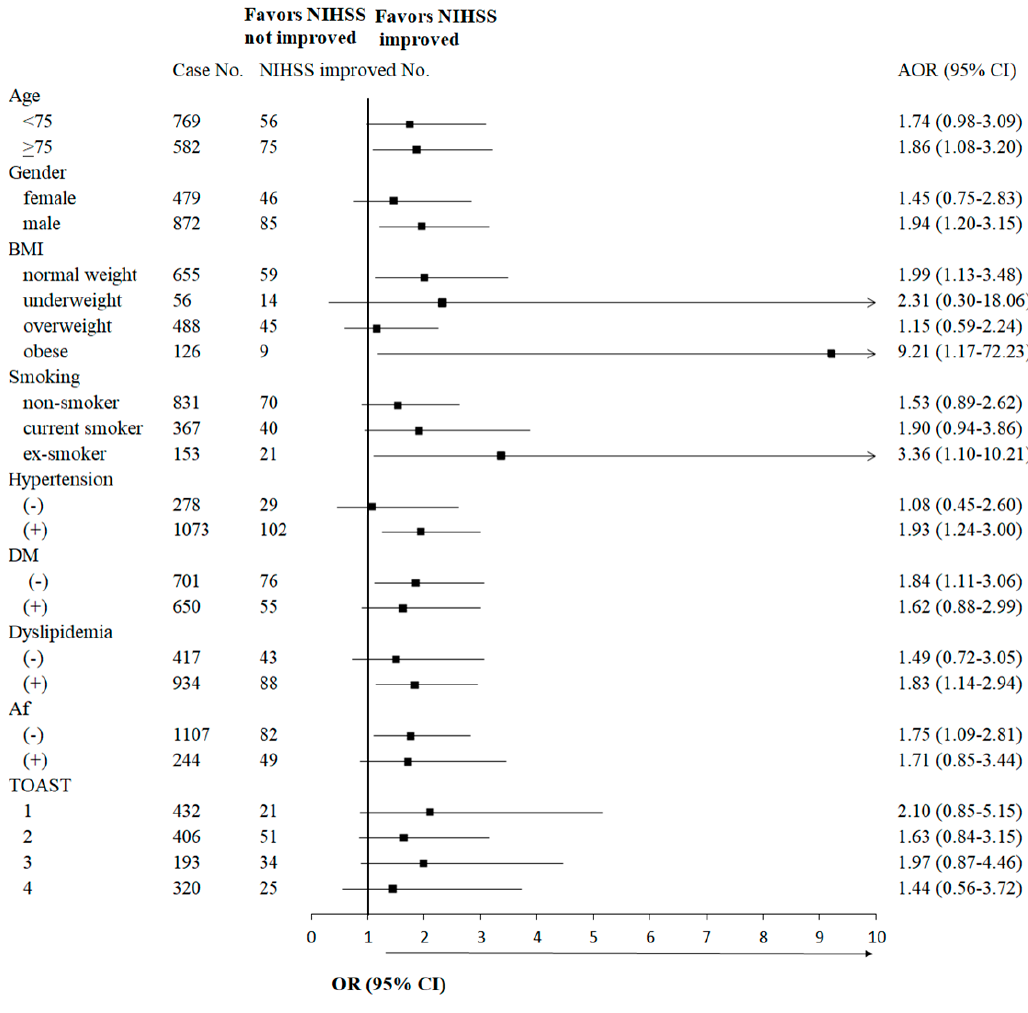
Figure 2. Subgroup analysis of epidemiological and comorbidity variables for the associations of piracetam with NIHSS score improvement. Association of piracetam treatment with NIHSS improvement was evaluated in each subgroup in each category. Logistic regression model was used for statistical analysis. NIHSS, National Institute of Health Stroke Scale; BMI, body mass index; DM, diabetes mellitus; Af, atrial fibrillation; TOAST, Trial of Organization 10,172 in Acute Stroke Treatment classification; 1, small-vessel occlusion; 2, large-artery atherosclerosis; 3, cardioembolism; 4, others; ( − ), negative; (+), positive; AOR, adjusted odds ratio, adjusted among the categories including age, gender, BMI, smoking habit, hypertension, DM, dyslipidemia, Af and TOAST; 95% CI, 95% confident interval.